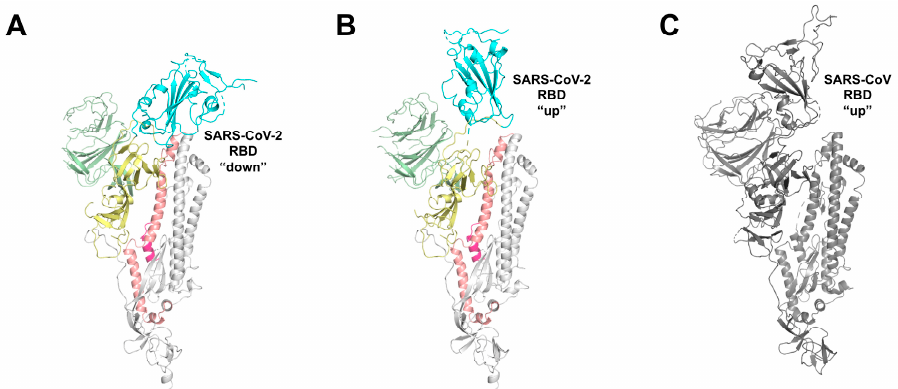
Figure 2. Receptor binding domain (RBD) “down” and “up” conformations of SARS-CoV-2. ( A ) Single protomer of SARS-CoV-2 with the RBD in the down conformation, displayed as cartoon (PDB ID: 6VSB). RBD is colored cyan, the N-terminal domain (NTD) is pale green, subdomains 1 and 2 (SD1 and SD2) are yellow, the S2 domain is white, with HR1 colored salmon and FP hotpink. ( B ) Single protomer of SARS-CoV-2 in the RBD up conformation next to ( C ) a protomer of SARS-CoV (colored gray) in the RBD up conformation (PDB: 6CRZ).